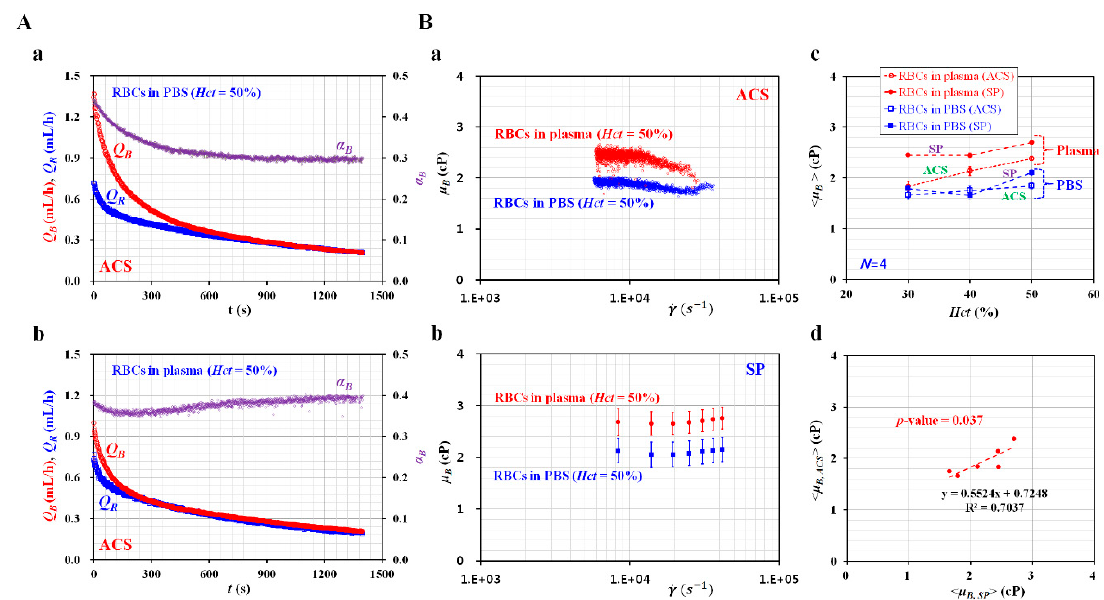
Figure 4. Quantitative comparison of blood viscosity for blood samples (normal RBCs in plasma and PBS, Hct = 50%) with respect to the fluid delivery system (ACS, SP). ( A ) Variations of flow rates ( Q B , Q R ) and interface ( α B ) with respect to the base solution (1× PBS, plasma). ( a ) Temporal variations of Q B , Q R , and α B for a blood sample (normal RBCs in 1× PBS, and Hct = 50%). ( b ) Temporal variations of Q B , Q R , and α B for a blood sample (normal RBCs in plasma, and Hct = 50%). ( B ) Variation of blood viscosity depending on the base solution, hematocrit, and fluid delivery system (ACS and SP). ( a ) Variations of blood viscosity ( μ B ) of blood samples with respect to the base solution (1× PBS, plasma) and shear rate under fluid delivery of ACS. ( b ) Variations of μ B with respect to the base solution (1× PBS, plasma) and shear rate under fluid delivery of two SPs. ( c ) Variations of < μ B > with respect to base solution (1× PBS, plasma), hematocrit ( Hct = 30%, 40%, and 50%), and fluid delivery system (ACS, SP). < μ B > was quantified as < μ B > = mean ± standard deviation by conducting an arithmetic average of μ B obtained over shear rates. ( d ) Correlation between blood viscosity obtained under ACS (< μ B , ACS >) and blood viscosity obtained under SP (< μ B , SP >).